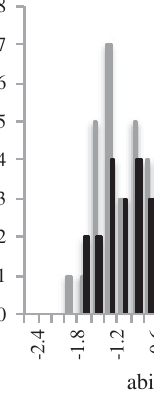
FIG. 39. The pre- and postability histogram for class 25.